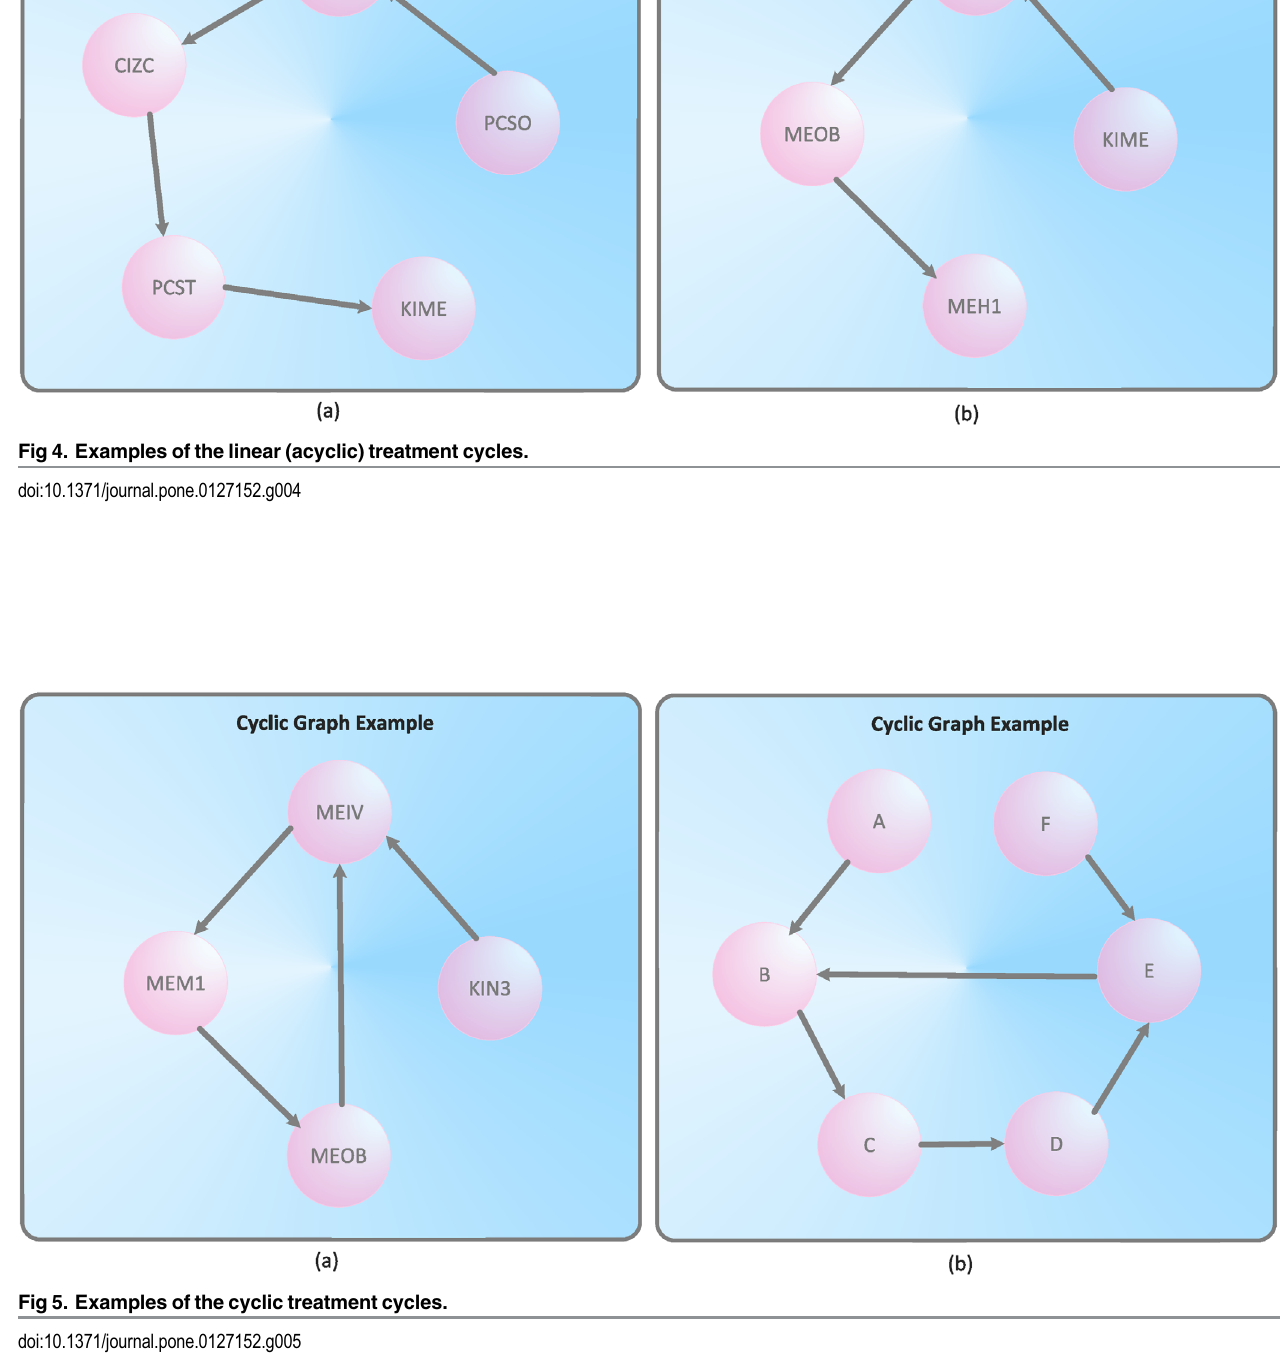
PLOS ONE | DOI:10.1371/journal.pone.0127152 June 1,